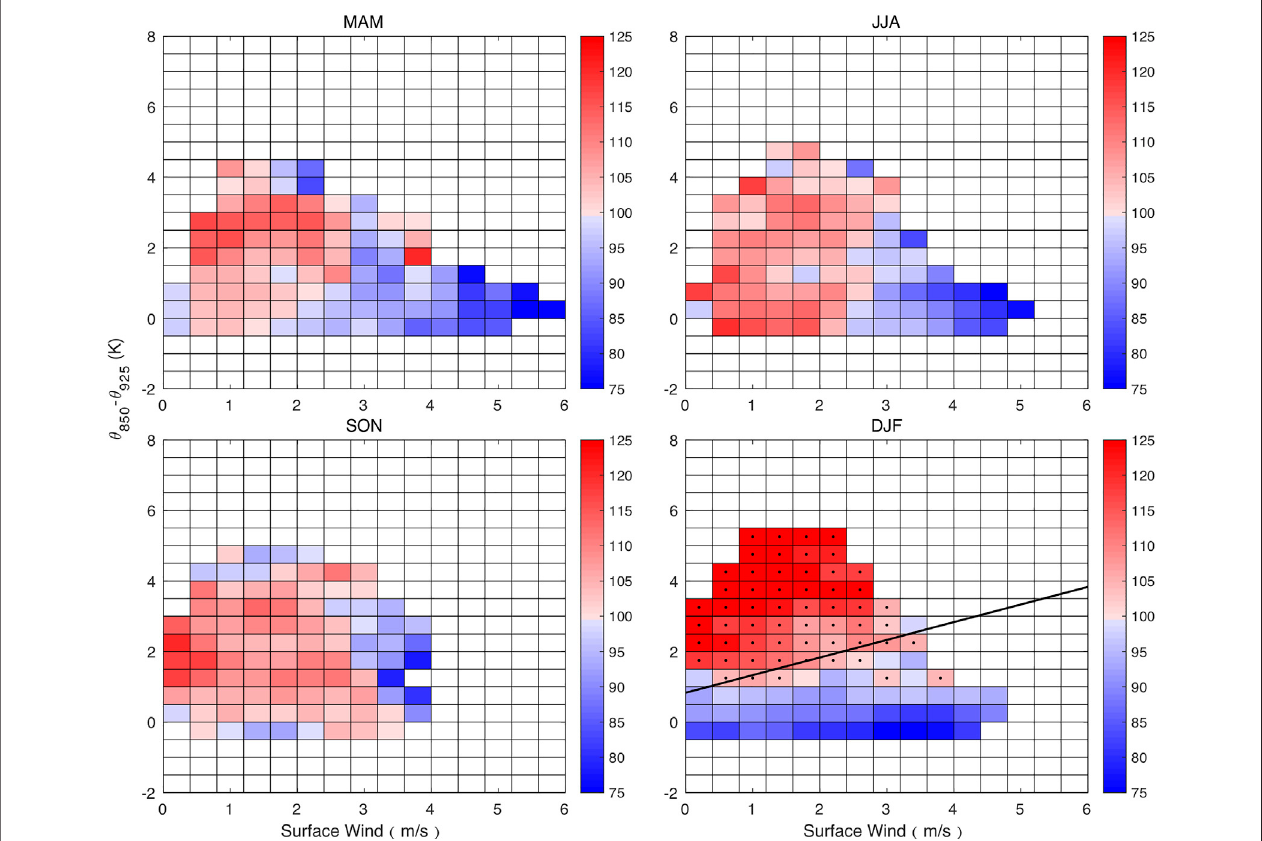
FIGURE 3 | Seasonal dependence of normalized PM2.5 concentrations on the 10-m wind speed (Wind_10) and potential temperature difference between 925 hPa and 850 hPa ( Δ θ ) (unit of normalized PM2.5 is %). Dots in winter indicate the normalized PM2.5 concentration of the speci fi c grid greater than 100% (higher than its monthly mean). The black line in winter indicates the threshold of the air stagnation condition based on the locations of dots. Grids with sample sizes greater than 100 are shown here.